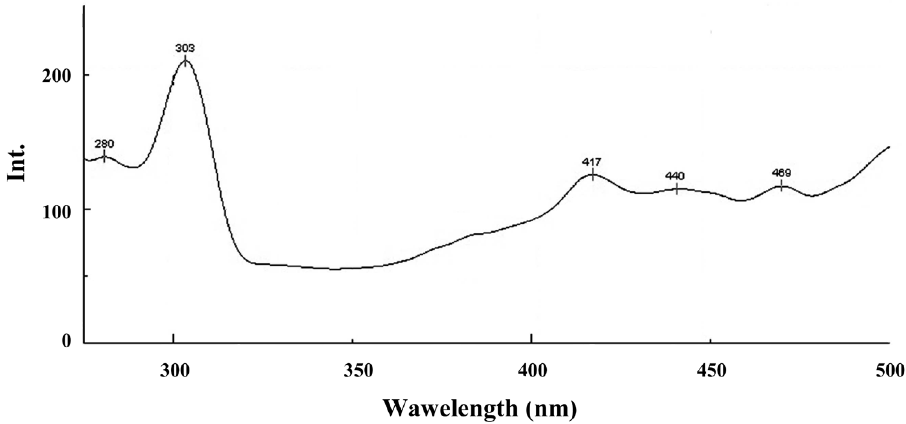
Figure 6. FP spectra of the sample of solid phase of M . graniger dragani ( λ ex = 265 nm) (Int.- intensity of the